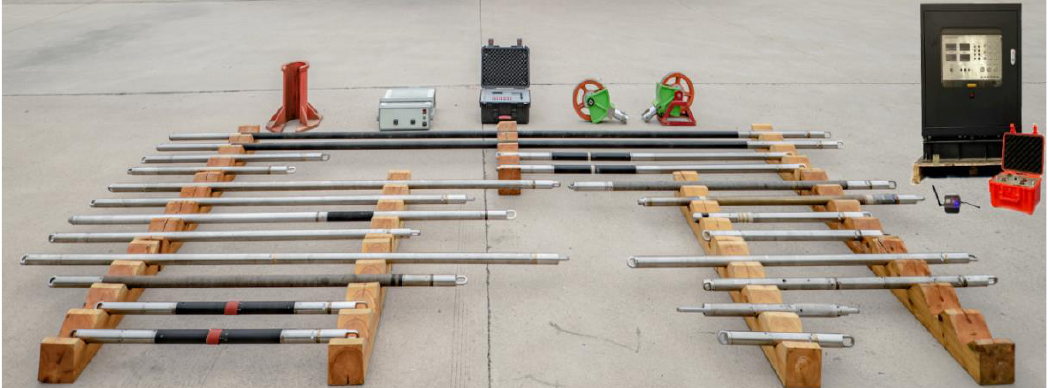
Figure 17. Real picture of the induced polarization logging device.